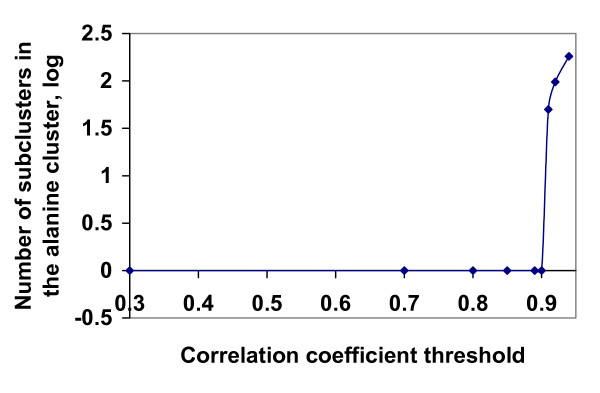
The number of subclusters in the alanine cluster obtained from the BLOCKS database as a function of the correlation coefficient threshold employed in the clustering procedure. Note the sharp rise in the number of subclusters when the correlation coefficient threshold is slightly greater than 0.9.